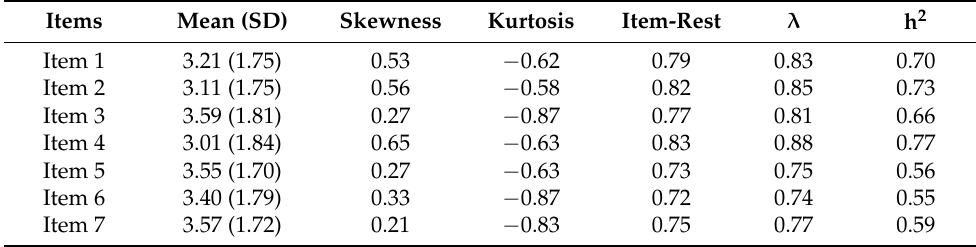
Table 2. Descriptive and psychometric characteristics of the AAQ-II items ( n =